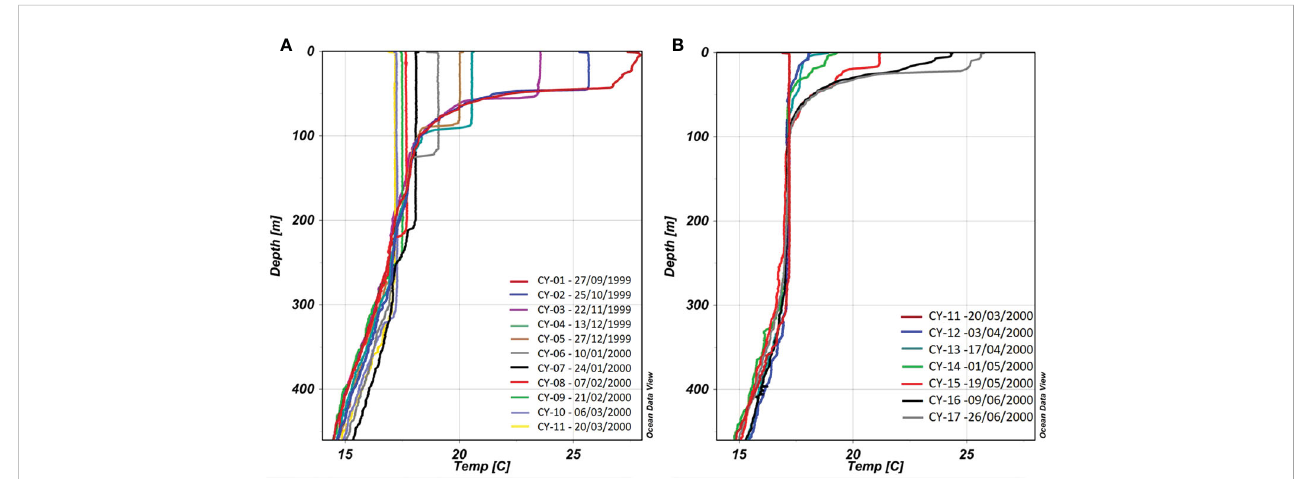
FIGURE 13 The bi-weekly evolution of the temperature pro fi les in the core of the Cyprus Eddy during the MFSPP project (Table 1B): (A) surface cooling erosion of the thermocline and deepening of the mixed from surface down to 320 m from Sep 1999 to Mar 2000; and (B) surface warming and restrati fi cation of the upper water column from Mar to June 2000.